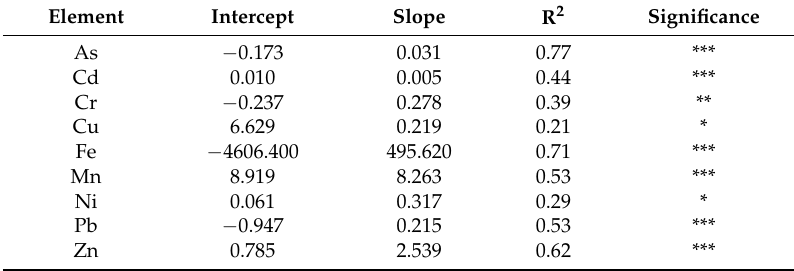
Table 3. Results of linear regression analysis determining the relationship between ash content (% DM) and heavy metal concentration (mg · kg − 1 DM) in leaf litter of urban street trees. Residuals of the models for Ni, Fe and Cu were not normally